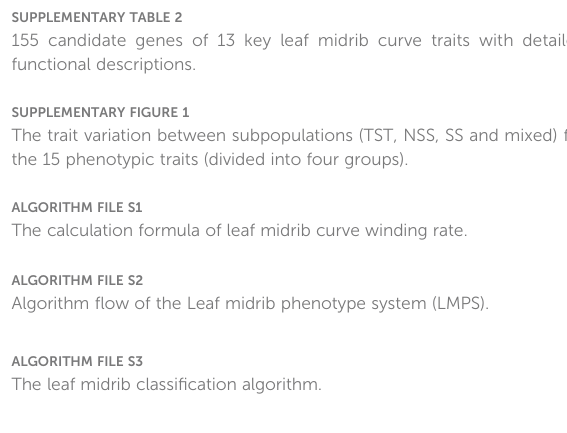
SUPPLEMENTARY TABLE 1 The leaf midrib phenotypic indexes and their calculation description. SUPPLEMENTARY TABLE 2 155 candidate genes of 13 key leaf midrib curve traits with detailed functional descriptions.